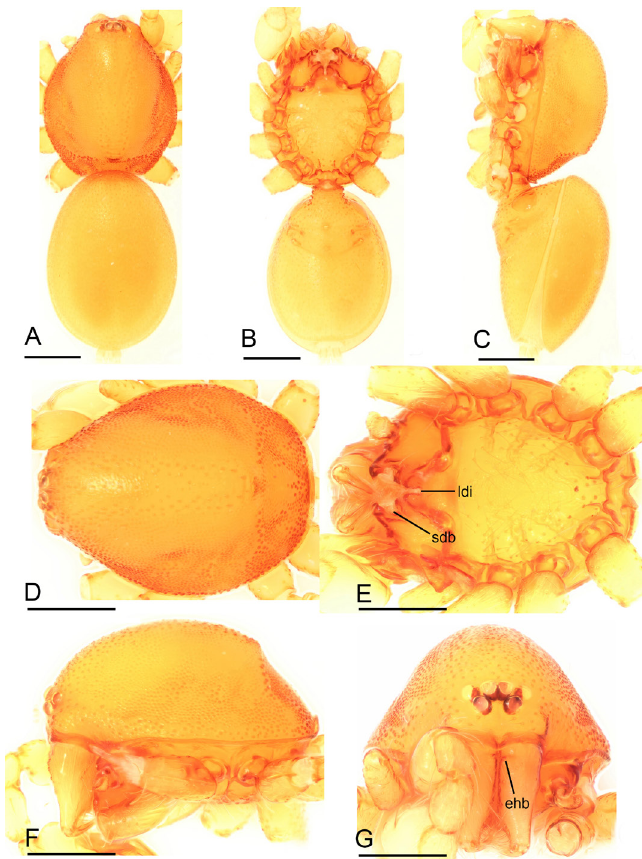
Fig. 1. Trilacuna jinyun Tong, Zhang & Li sp. nov., holotype, ♂ (SYNU-291). A – C . Habitus in dorsal, ventral, and lateral views. D – G . Prosoma in dorsal, ventral, lateral, and anterior views. Abbreviations: ehb = elevated hair base; ldi = labium deep incision; sdb = strongly curved distal branch. Scale bars: 0.4